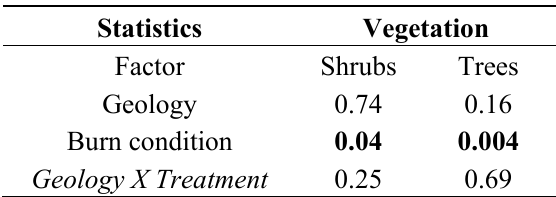
Table 1. Two factor analysis of variance for total number of trees and shrubs. Bold numbers indicate significance at α =